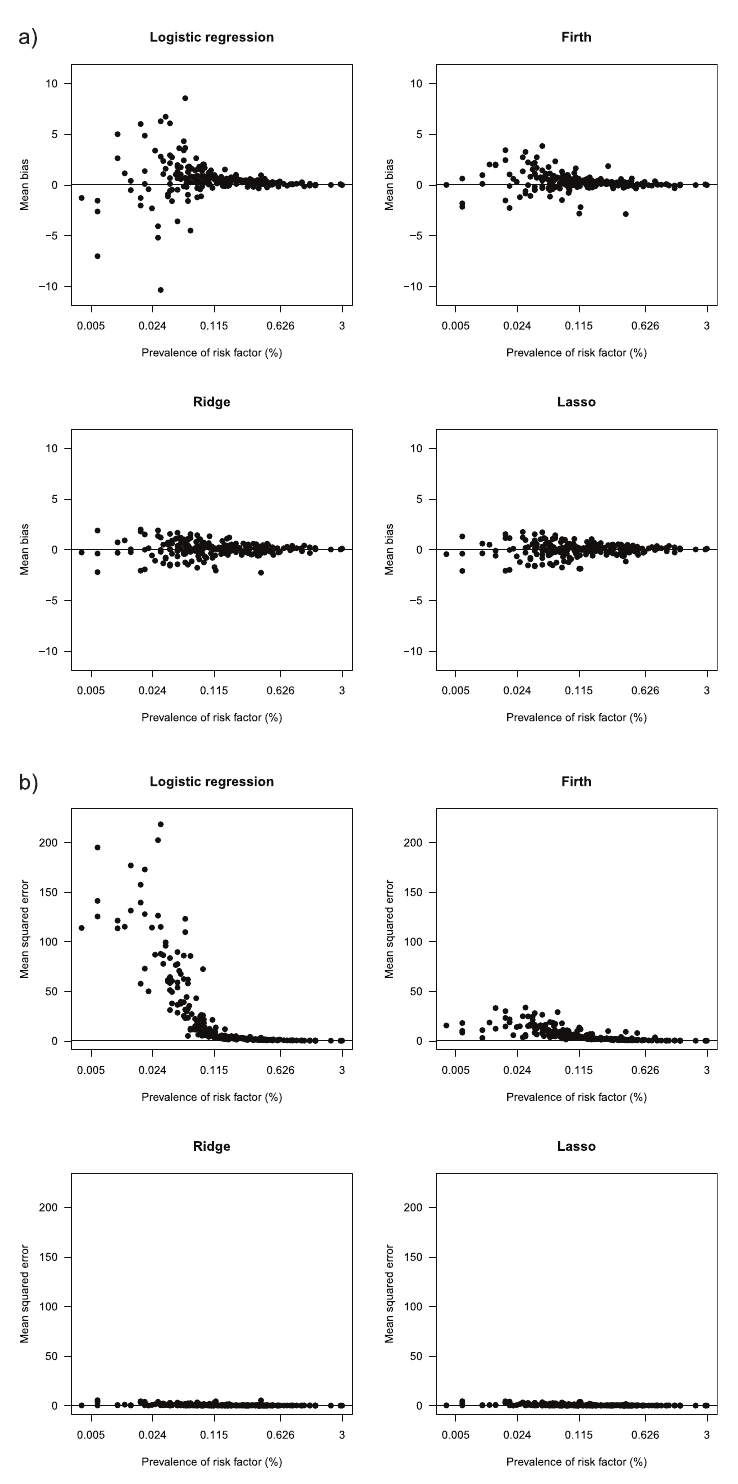
Fig 1. Case-control data. In the whole cohort of 50,728 drivers, we fit a reference model using logistic regression. We take 100 subsamples without replacement of 10,000 drivers and fit logistic, Firth, ridge and the lasso estimates. The bias ( 1a ) and mean squared error ( 1b ) of 213 risk factors shown are in comparison to the estimates of the reference model. The prevalence is on a log scale.